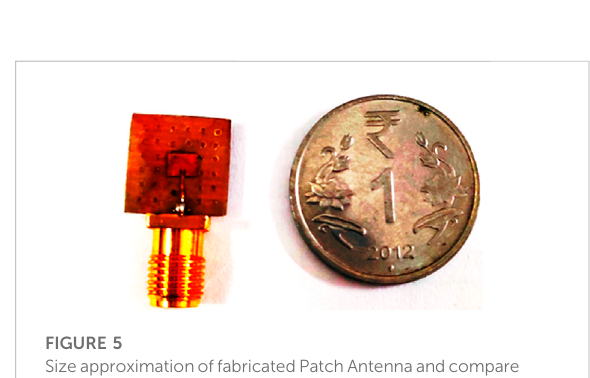
FIGURE 5 SizeapproximationoffabricatedPatchAntennaandcompare with rupee